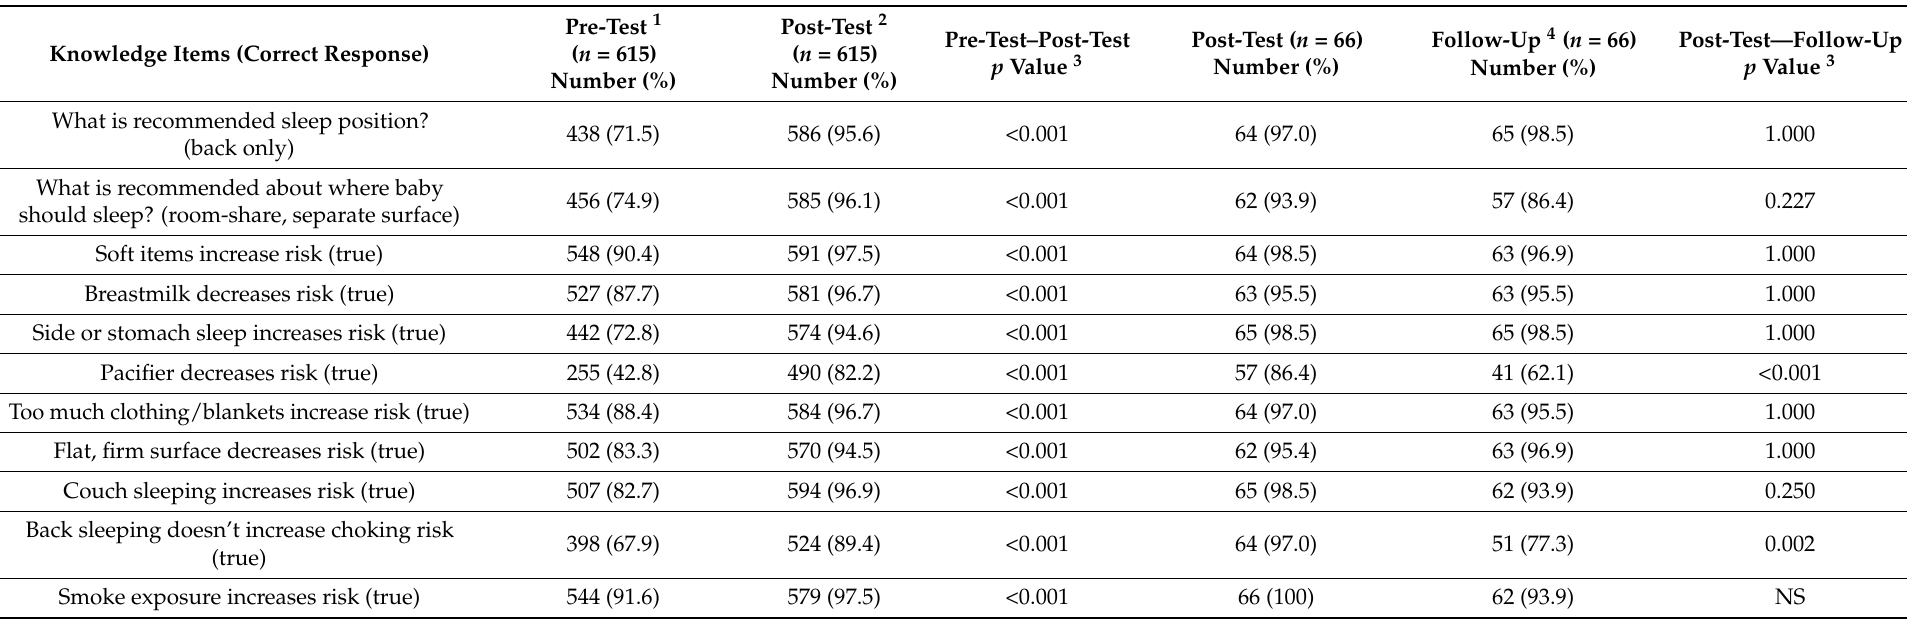
Table 2. Knowledge—comparison of correct responses on matched